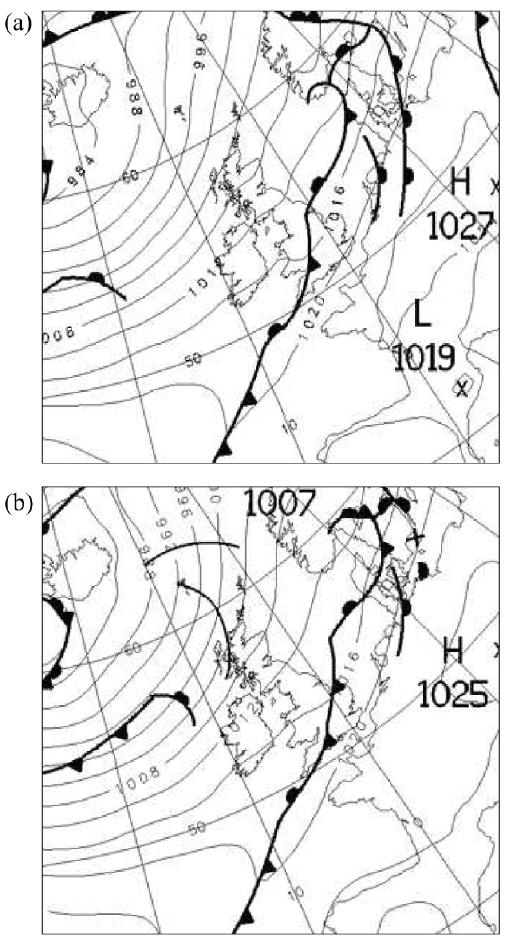
Fig. 3. Met Office mean sea level pressure analysis charts valid at (a) 12:00UTC and (b) 18:00UTC 20 September 2011. Grey pres- sure contours every 4hPa. © Crown Copyright 2011, Met